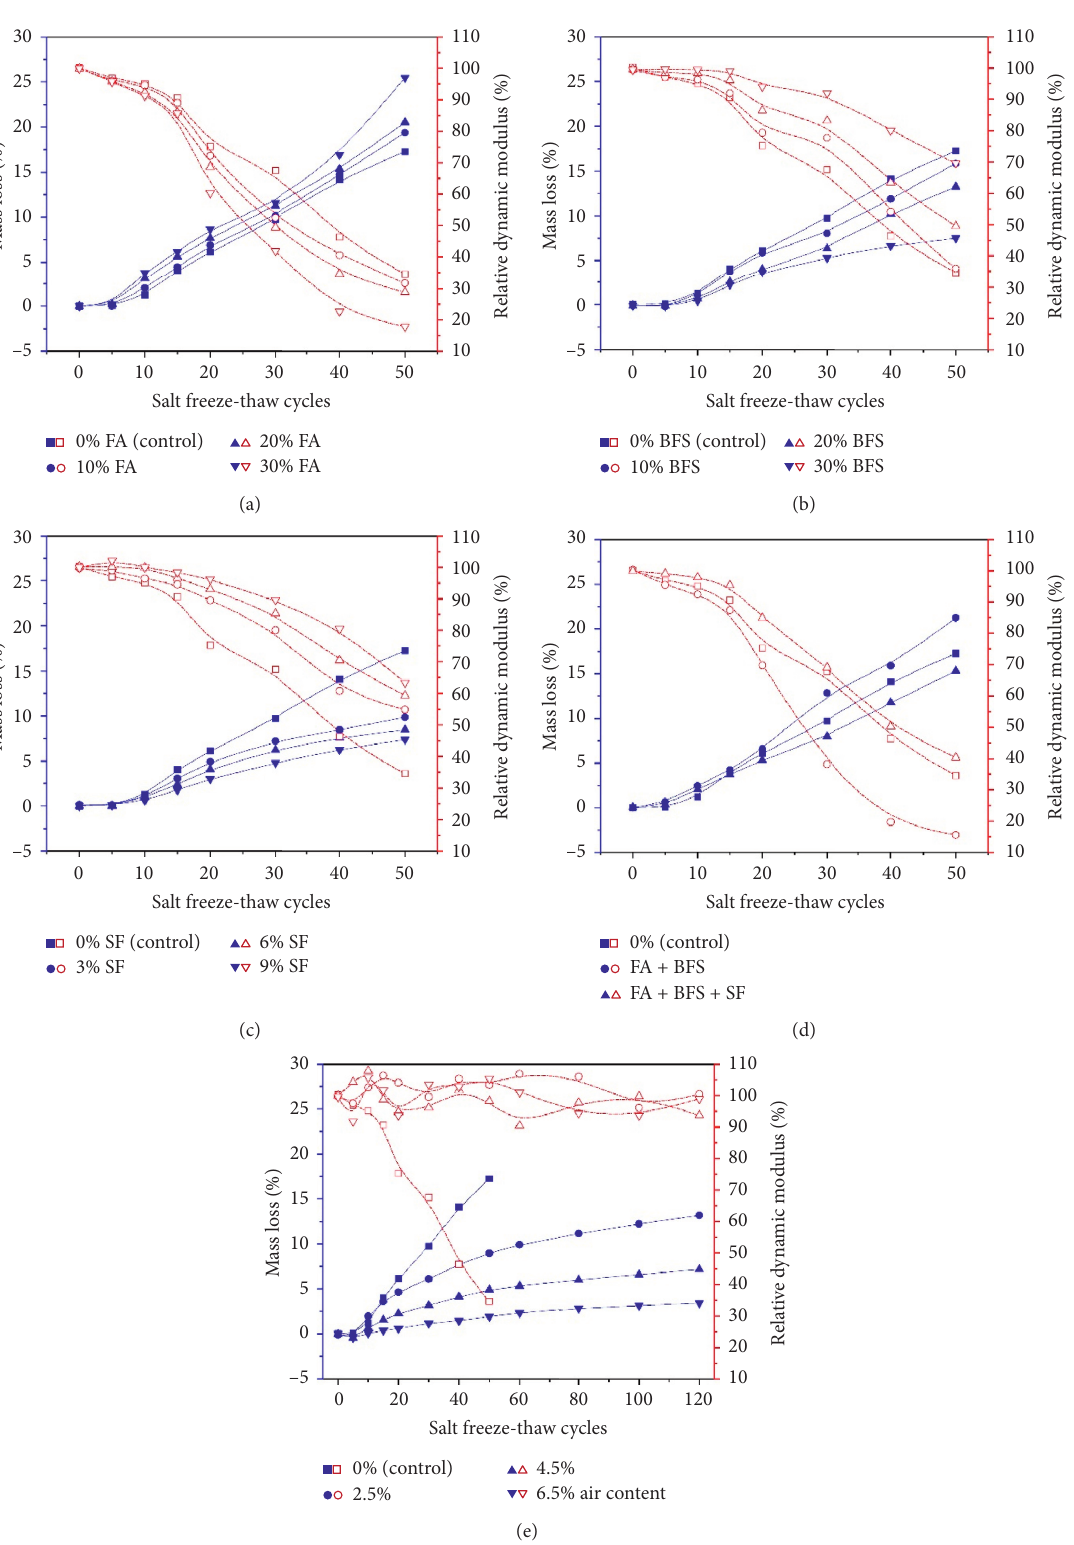
Figure 12: The salt freeze-thaw resistance of concretes with mineral admixtures. (a) FA. (b) BFS. (c) SF. (d) Multimineral admixtures. (e) Air